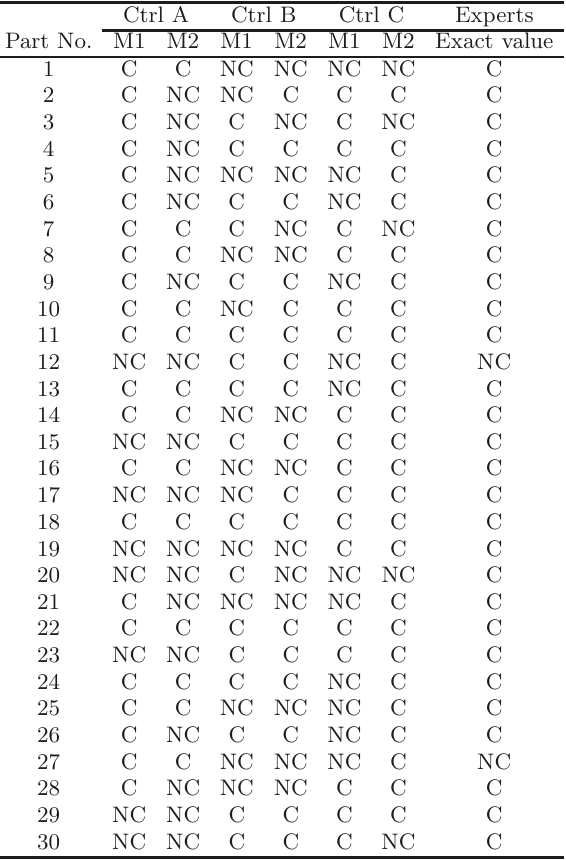
Table 1. R & R test on a visual inspection.